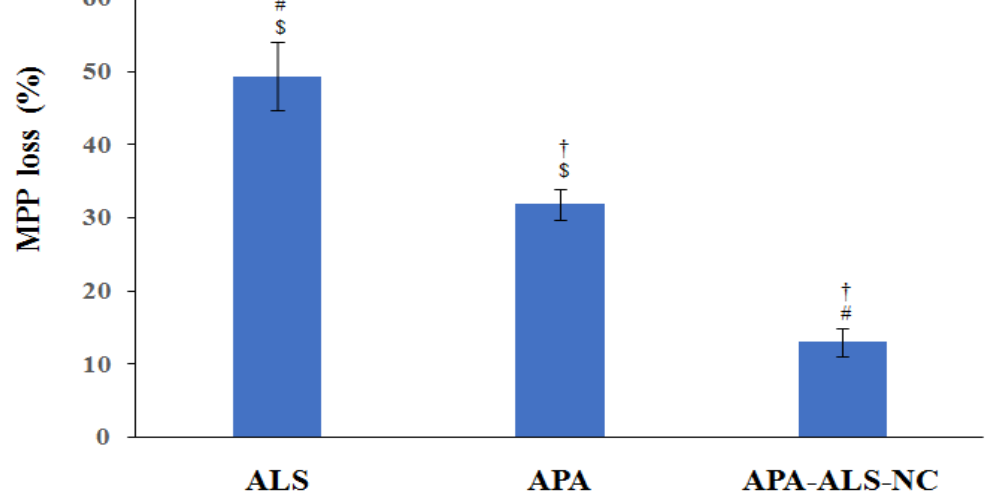
Figure 5. Mitochondrial membrane potential study results after treatment with ALS, APA, and APA-ALS-NC samples on PANC-1 cells. (Statistical inferences: † p < 0.05, in comparison to ALS; # p < 0.05, in comparison to APA; $ p < 0.05, in comparison to APA-ALS-NC).